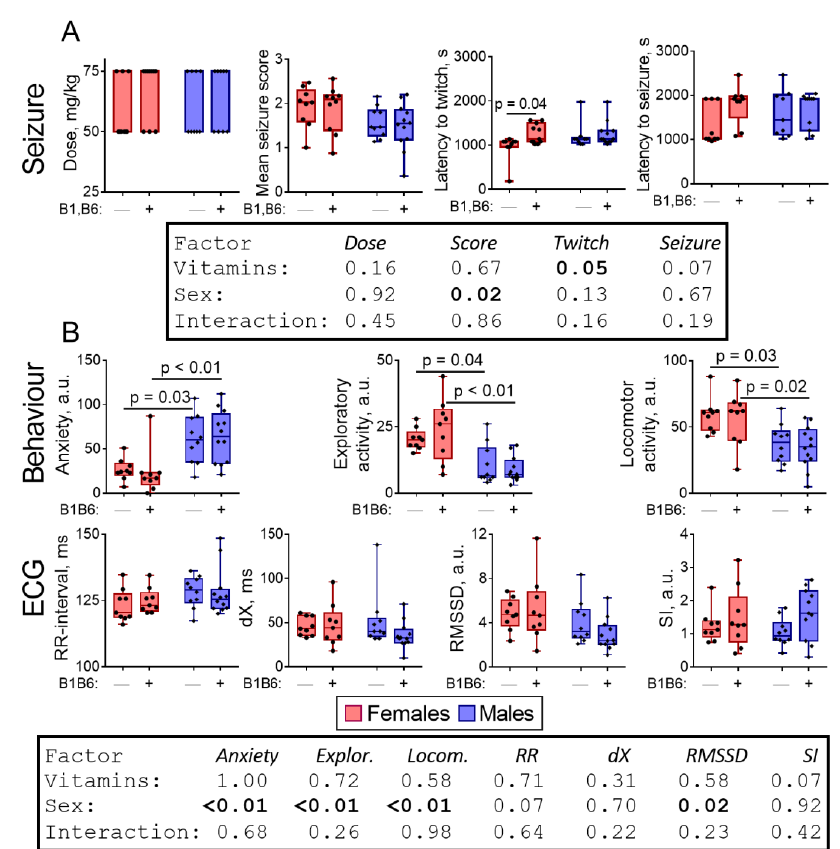
Figure 4. Sex-dependent effects of the administration of vitamins B1 and B6 on the parameters of the PTZ-induced seizure ( A ) and its delayed physiological effects ( B ). The assayed parameters are indicated on the Y axes and described in more details in Figure 1 and “Materials and methods”.